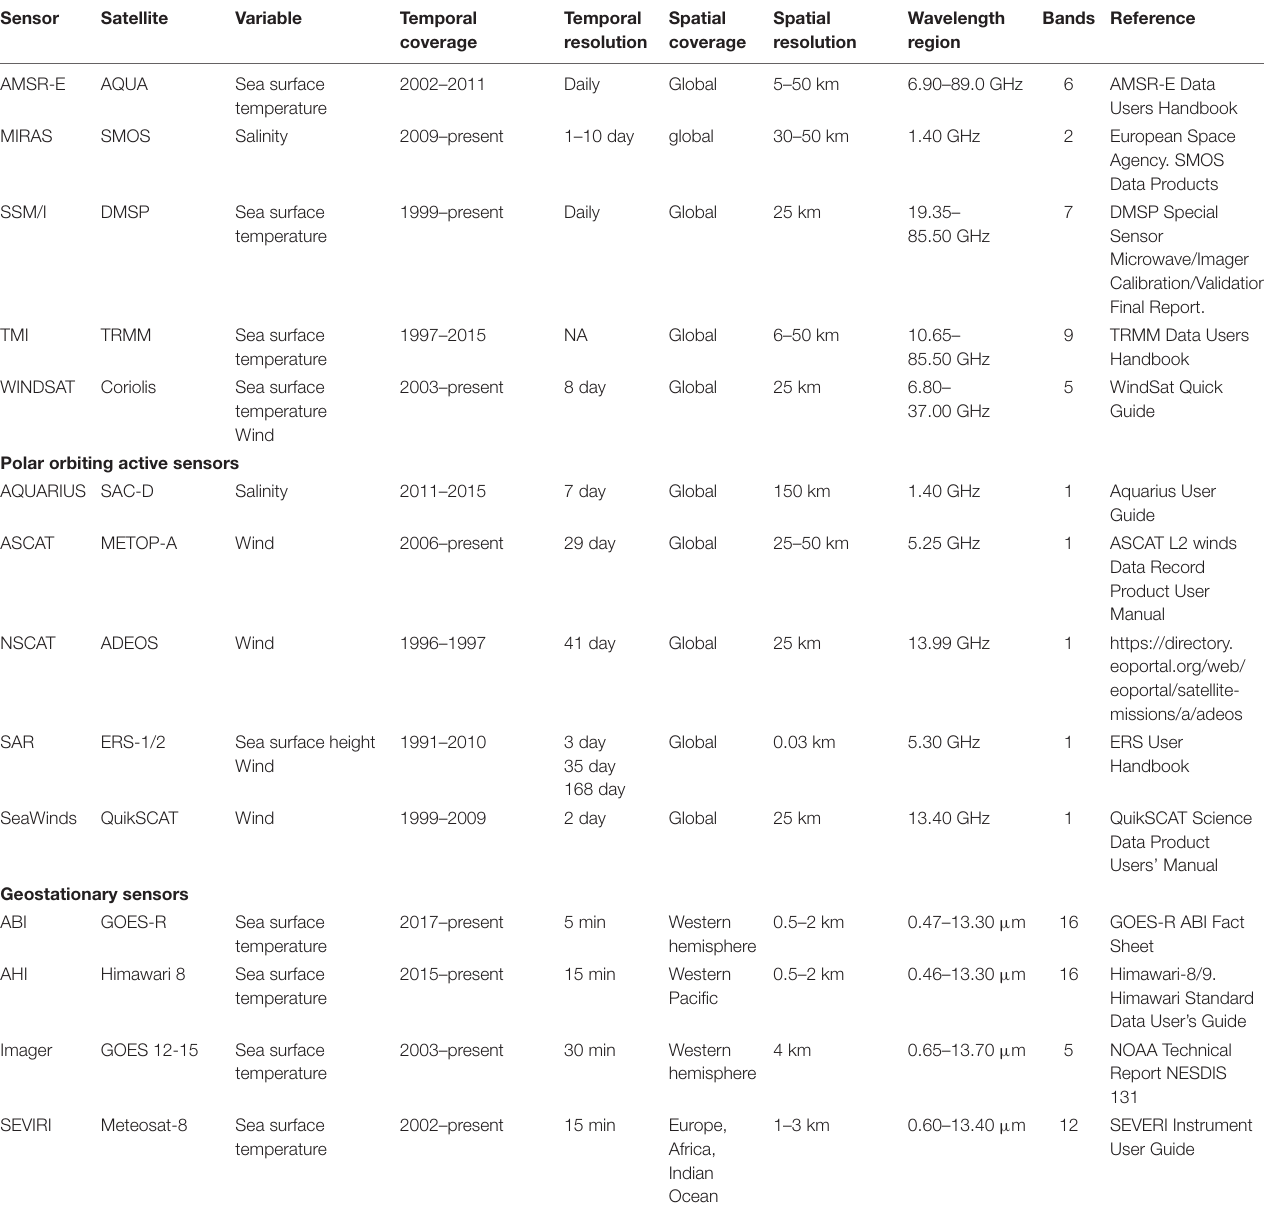
SEVERI Instrument User